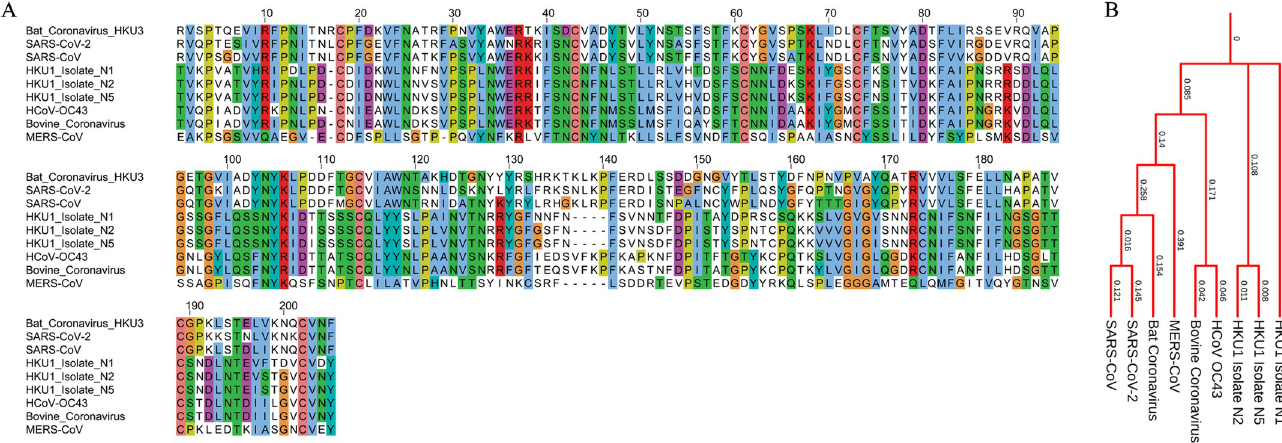
Fig 7. Phylogenetic profile of receptor binding domain of the spike glycoprotein of the coronavirus. (A) Multiple sequence alignment and (B) phylogenetic tree of the receptor-binding domain.